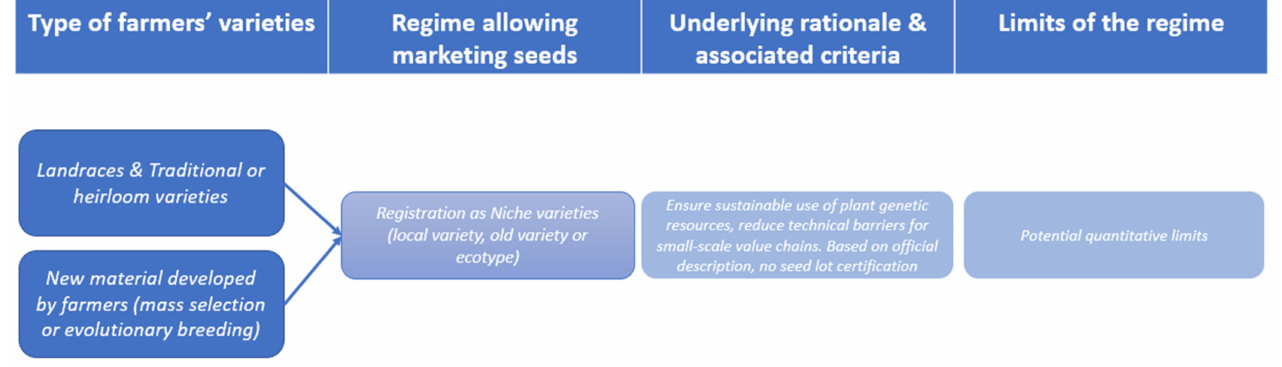
Figure 2. Pathway for the registration of farmers’ varieties in Switzerland. During the last 10 years working under the new Swiss ordinance, ProSpecieRara, a seed saver network working on the conservation and sustainable use of both plant and animal diversity, was able to reintroduce about 50 plant varieties into different marketing channels. Most of them were reintroduced in cooperation with the biggest supermarket chain in Switzerland that offers a large scale of organic vegetables. During all these years, ProSpecieRara never got in conflict with any quantitative or regional restrictions imposed by the actual directive described above. In general, ProSpecieRara construes seed savers communities, and larger associations engaged in labelling and